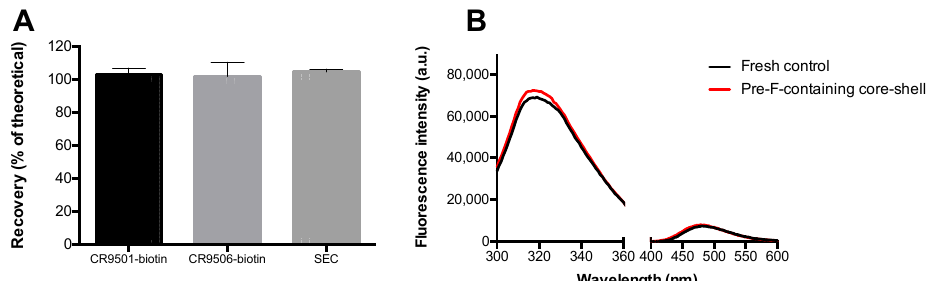
Figure 6. Analyses on the pre-F-containing core-shell implants to investigate the influence of the core-shell production process on the stability of pre-F. ( A ) shows the recovery (% of theoretical) of the pre-F-containing core-shell implants found with ELISA (CR9501-biotin (black bar) and CR9506-biotin (light grey bar) as detection antibodies) and SEC (dark grey bar). For each analytical technique, n = 3, mean and standard deviation are given. ( B ) shows the results of intrinsic (300–360 nm) and extrinsic (400–600 nm) fluorescence spectroscopy of the pre-F-containing core-shell implants (red line) compared to a fresh unprocessed control with the same theoretical concentration (black line). For each group, the mean of three independent measurements is shown. Since the curves almost completely overlapped, error bars are not presented.